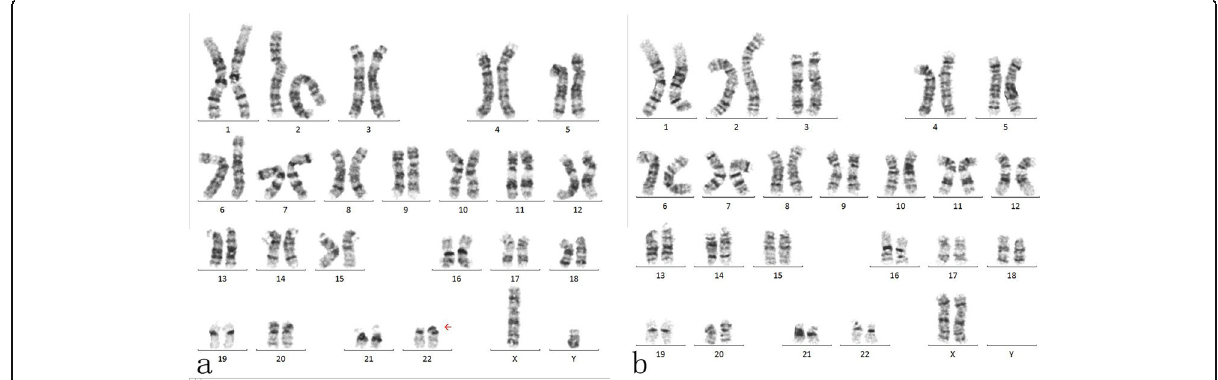
Fig. 2 Chromosomal analysis results for ( a ) the paternal sample and ( b ) the maternal sample